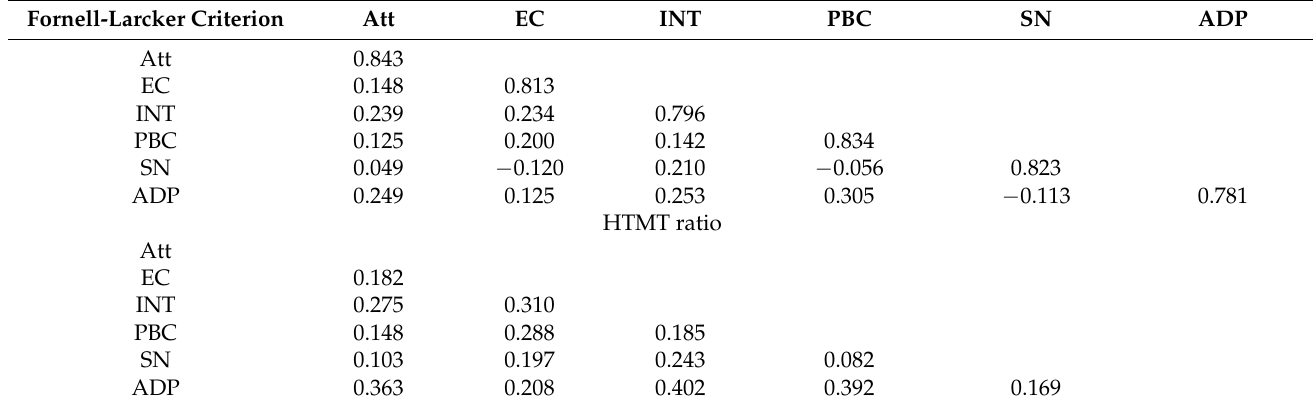
Table 3. Results of discriminant validity.